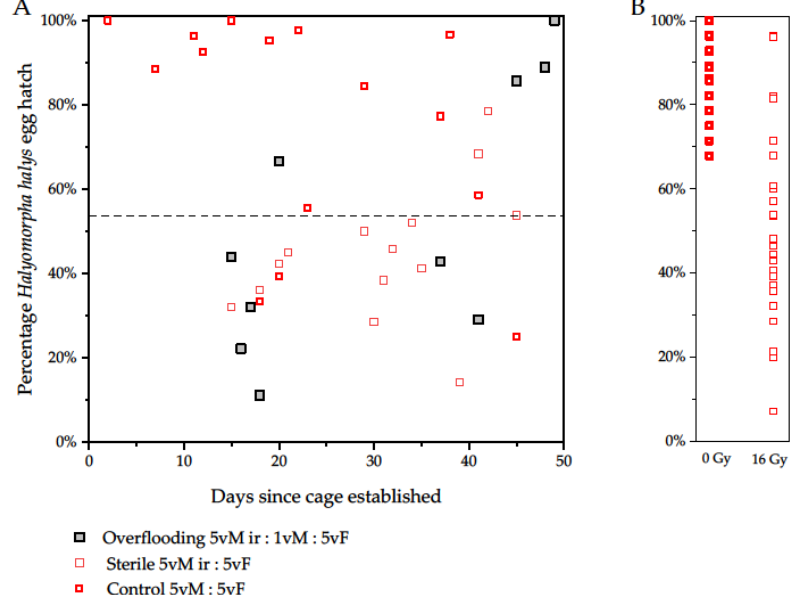
Figure 3. ( A ) Halyomorpha halys egg hatch over time as a function of overflooding with a five-to-one ratio of sterile to untreated virgin males (filled grey centre), compared with presumptively fully-sterile × virgin crosses (thin bordered square) and untreated controls (solid bordered square), with 15 virgin females per cage. The line shows the average fertility (54%) for parental male irradiation at 16 Gy. The results on the right ( B ) are from Experiment 2 (Figure 2), showing the spread of egg hatch values from 0 and 16 Gy treatments.